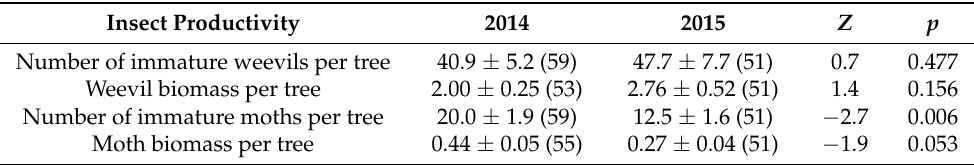
Table 3. Number and biomass (g) of immature weevils and moths produced per Quercus faginea tree in two consecutive fruiting seasons. Values are mean ± SE (number of trees), Z statistics and associated p -values from generalized linear models testing for differences in productivity variables between the two